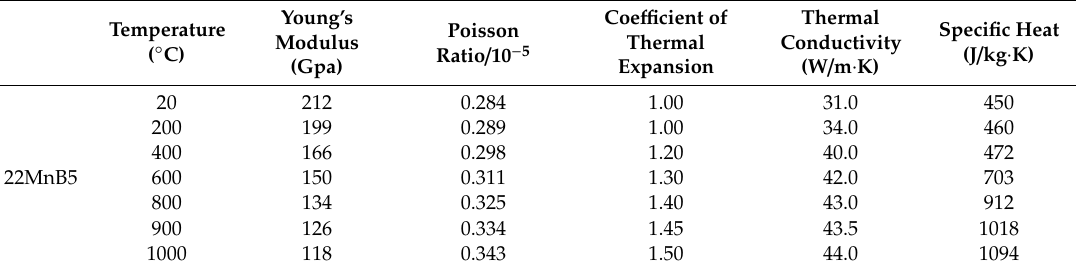
Table 2. Main mechanical properties of ultrahigh-strength steel